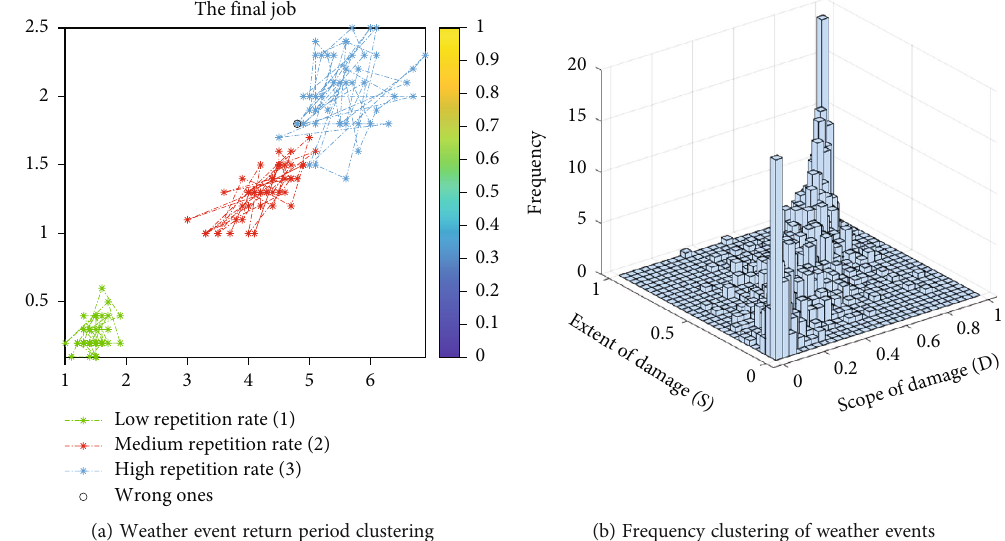
Figure 2: Weather event